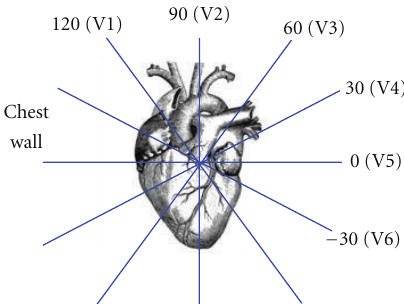
Figure 2: By joining the wires from the right arm, left arm, and left foot with 5000 Ohm resistors Frank Wilson defines an “indifferent electrode” later called the “Wilson Central Terminal.” The combined lead acts as an earth and is attached to the negative terminal of the ECG. An electrode attached to the positive terminal then becomes “unipolar” and can be placed anywhere on the body. Wilson defines the unipolar limb leads VR, VL, and VF where “V” stands for voltage (the voltage seen at the site of the unipolar